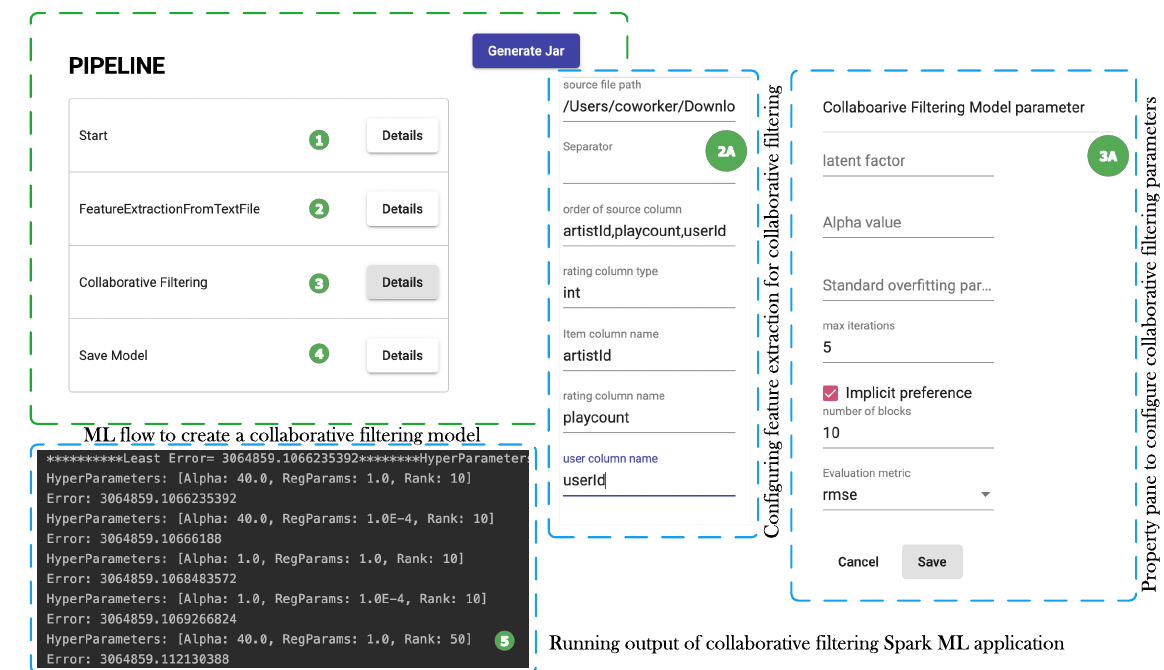
Figure 9. Graphical flow to create a collaborative filtering model for music recommendation.